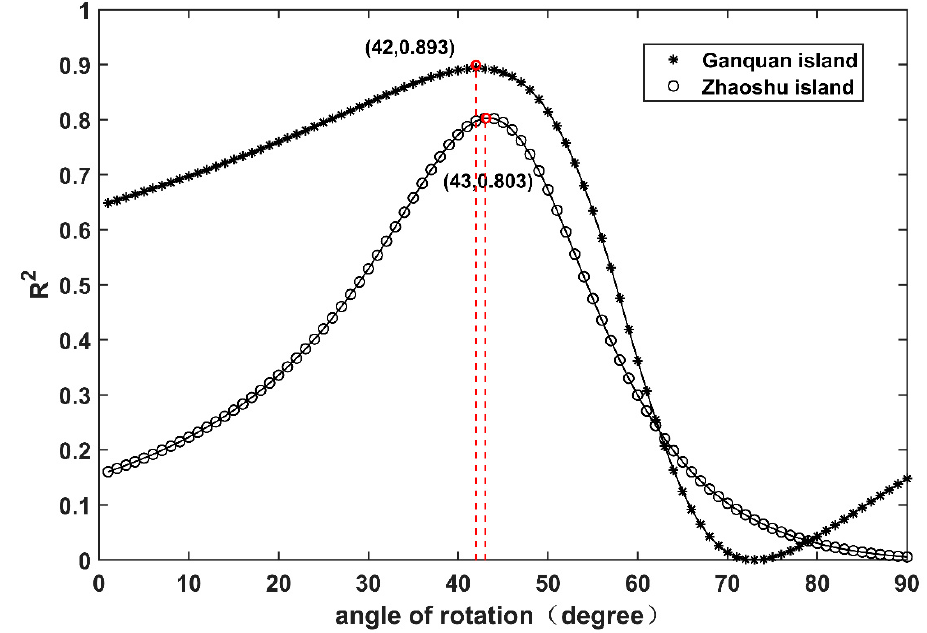
Figure 12. Correlations between α 1 X 1 + α 2 X 2 of [ α 1 , α 2 ] and the actual water depth at varying angles of rotation.